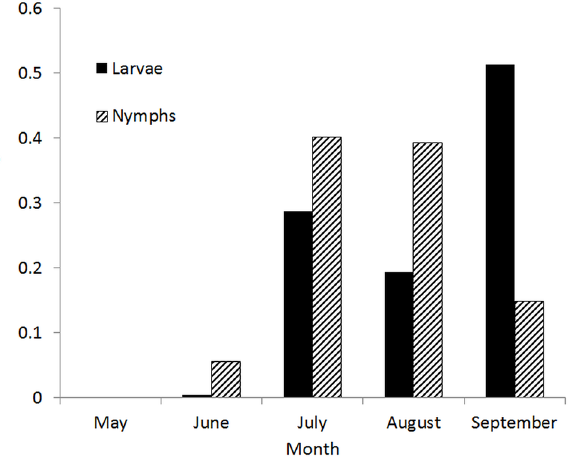
Fig 2. The seasonal activity of immature H . leporispalustris . The seasonality is expressed as the proportion of the total number of ticks of each instar collected in each month of the